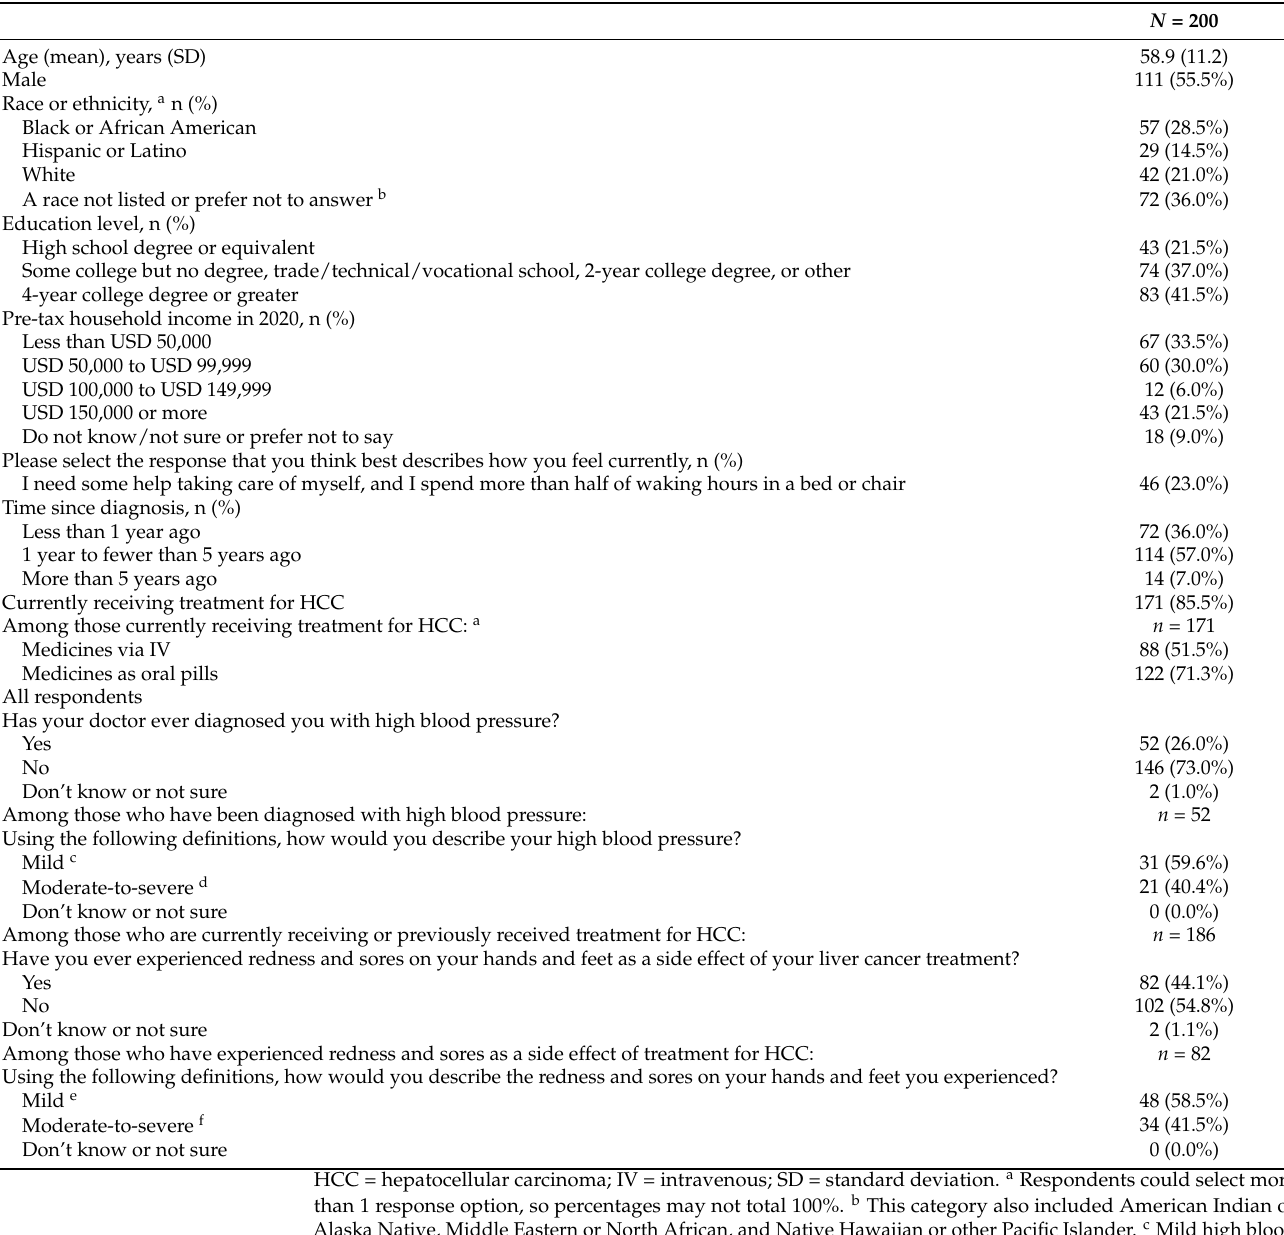
Table 2. Summary of patient